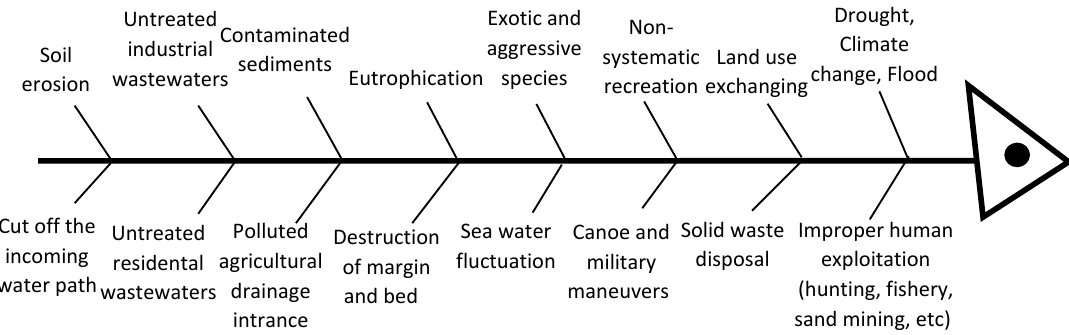
Fig. 2: The fish-bone model of anthropoid hazards causes and effects of Boujagh Wetland